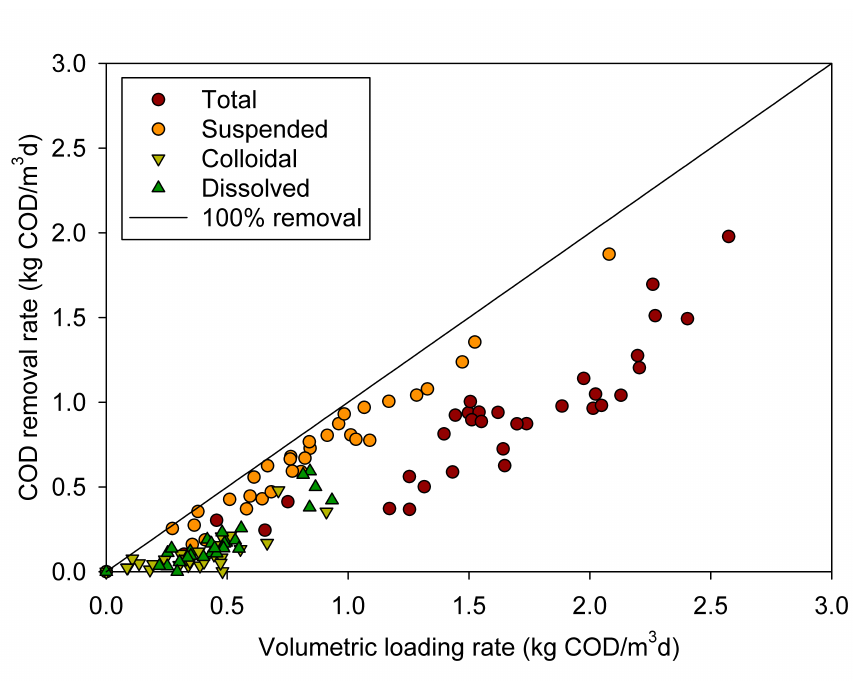
Figure 4. COD removal rate vs. volumetric loading rate in UASB12.